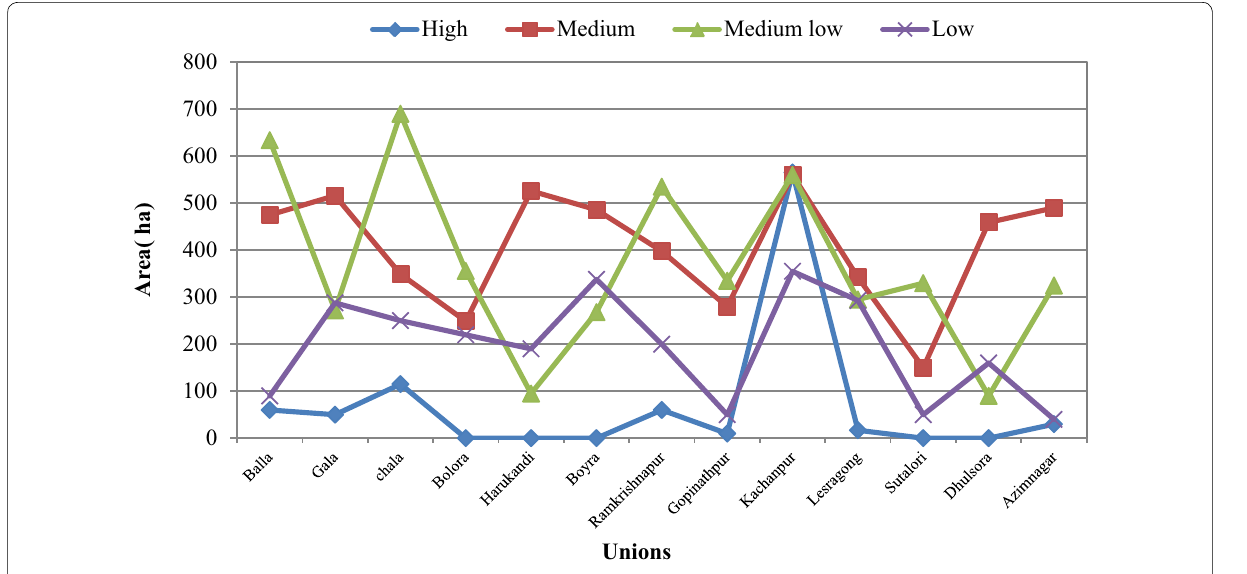
Fig. 3 Croplands of respective unions (Source: UNO office, 2015)